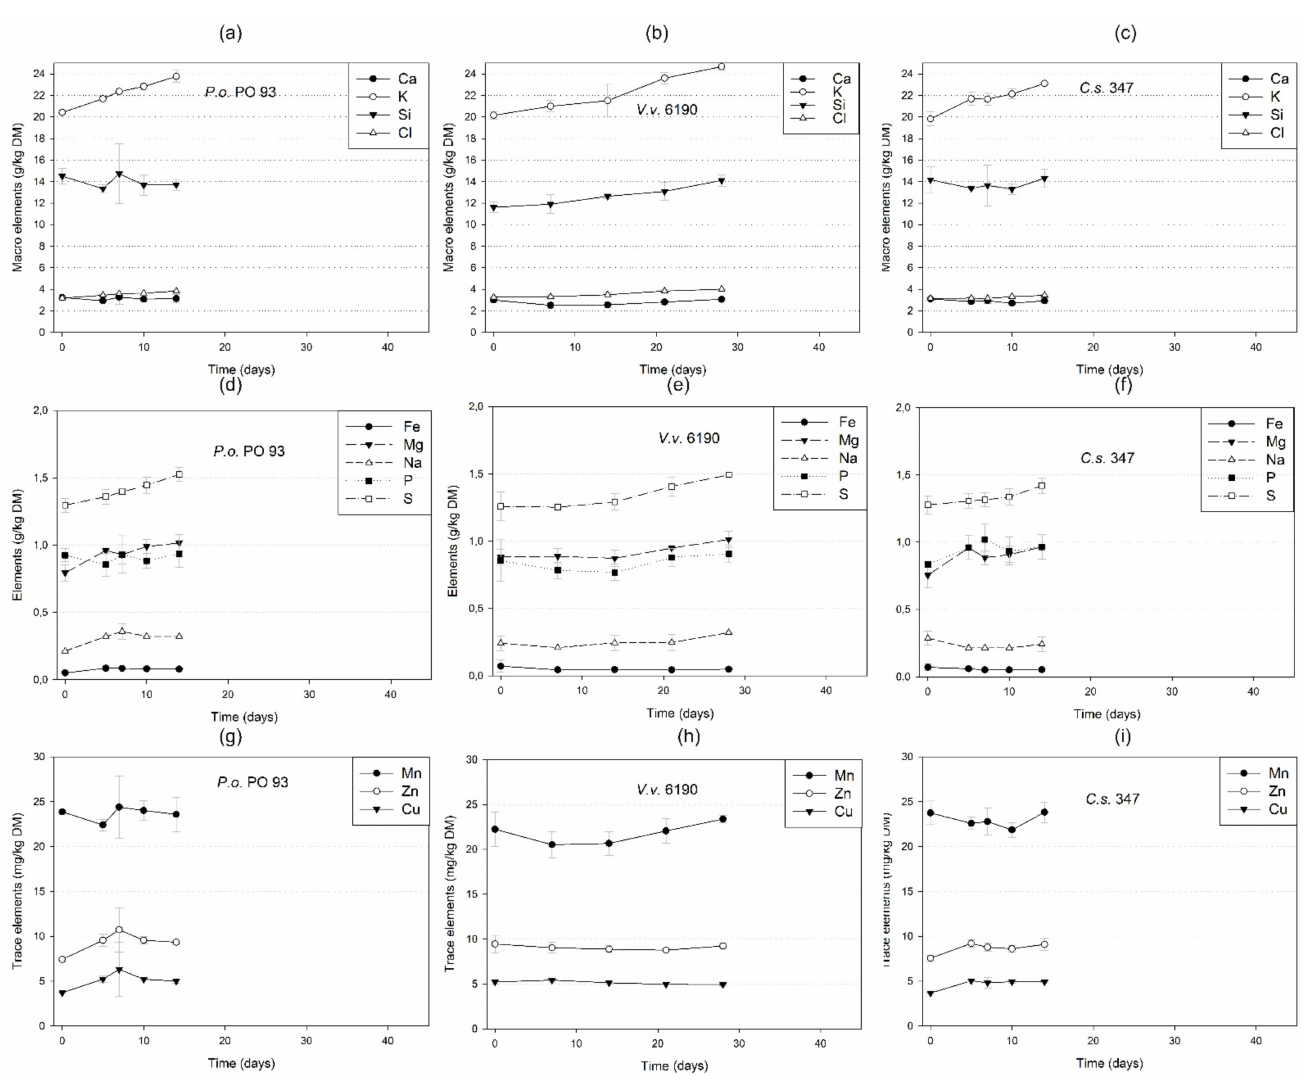
Figure 7. Macro and trace elements in fungi treated remoistened straw during up to 28 d of incubation. Left ( a , d , g ): inoculated with Pleurotus ostreatus ( P.o .) PO93, center ( b , e , h ): with Volvariella volvacea ( V.v. ), right ( c , f , i ): with Ceriporiopsis subvermispora ( C.s. ) CBS 347.63. First row ( a – c ): macro elements, second row ( d – f ): elements up to 2 g/kg DM, third row ( g – i ): trace elements. Error bars indicate the standard deviation